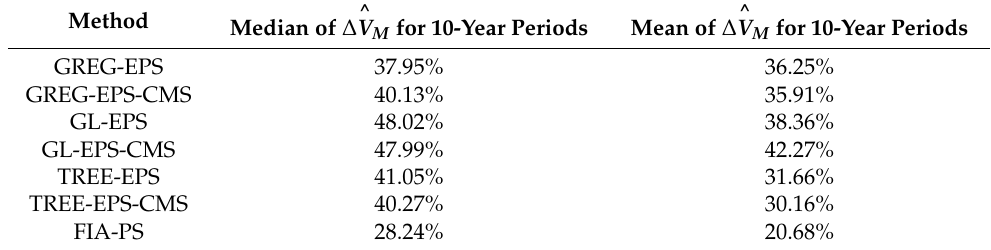
Table 4. Median and mean improvement of EPS and PS estimators for the HT